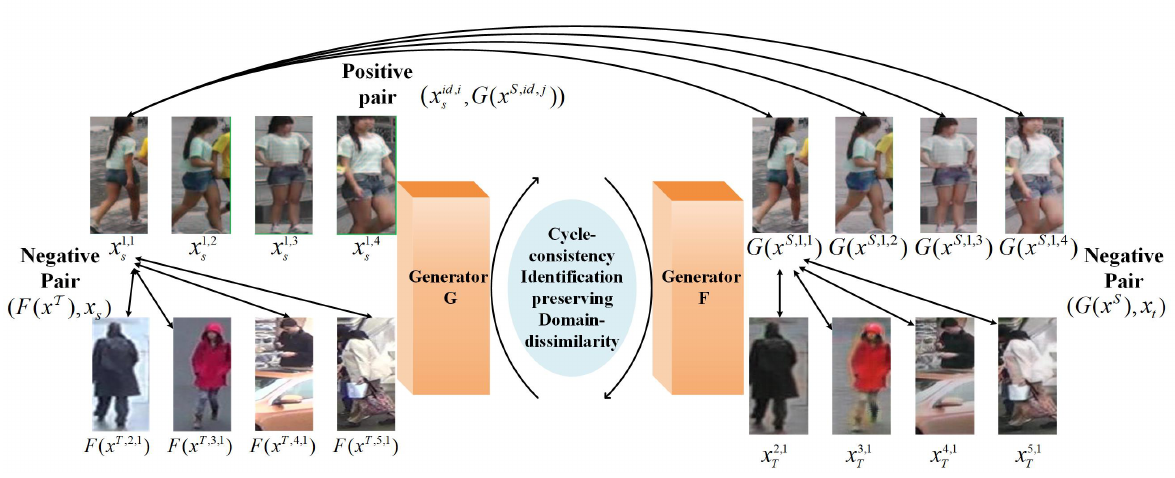
Figure 6. The image pair